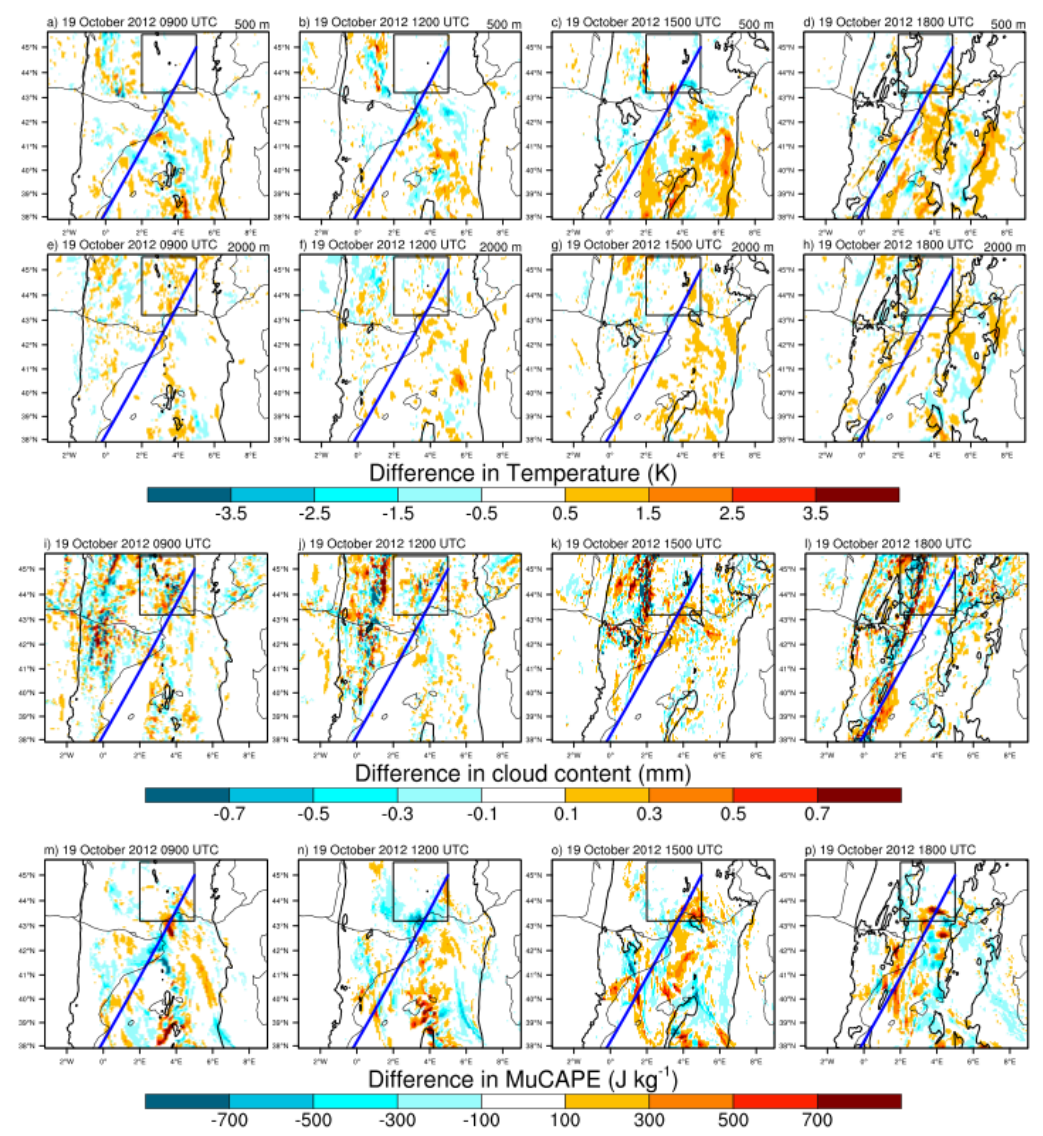
Figure 9. Top panels: 3-hourly field of difference in temperature at 500m between the DUST and NODUST simulations between 09:00 and 15:00UTC on 19 October (a–d) . Middle panels: same as top panels but for differences in temperature at 2500m (e–h) . Middle panels: 3-hourly field of difference in cloud content (i–l) . Bottom panels: as middle panels but for the difference in MuCAPE (m–p) . The black line shows the AOD of 0.1. The blue solid line indicates the position of the vertical cross sections shown in Fig. 8. The black box shows the CV